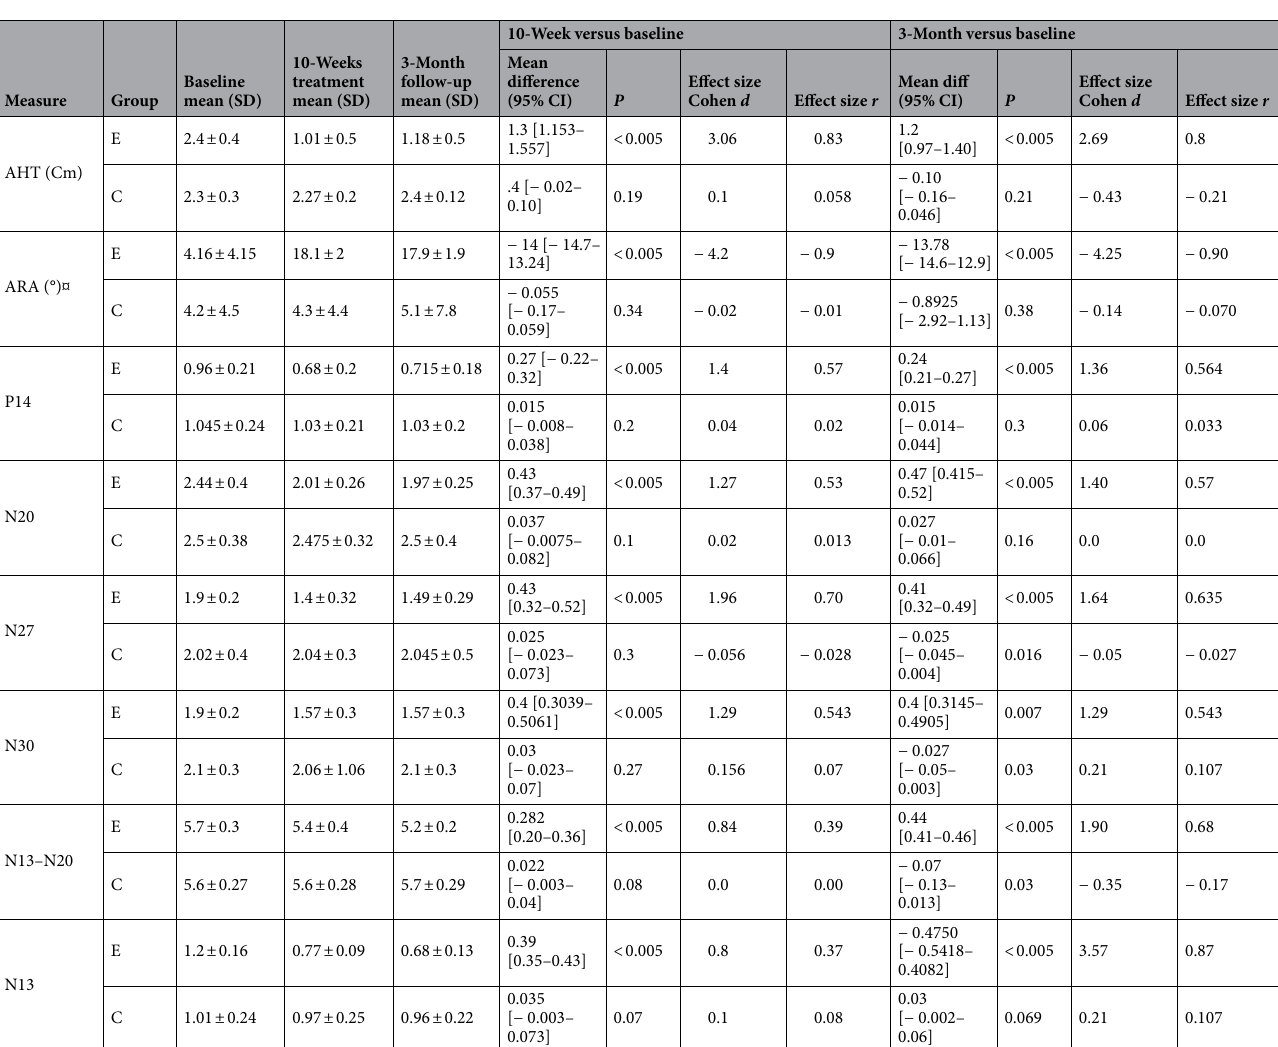
Table 3. Mean and standard deviations for all variables in the experimental and control groups at each evaluation period. Comparison of changes in outcome measures over time within each treatment